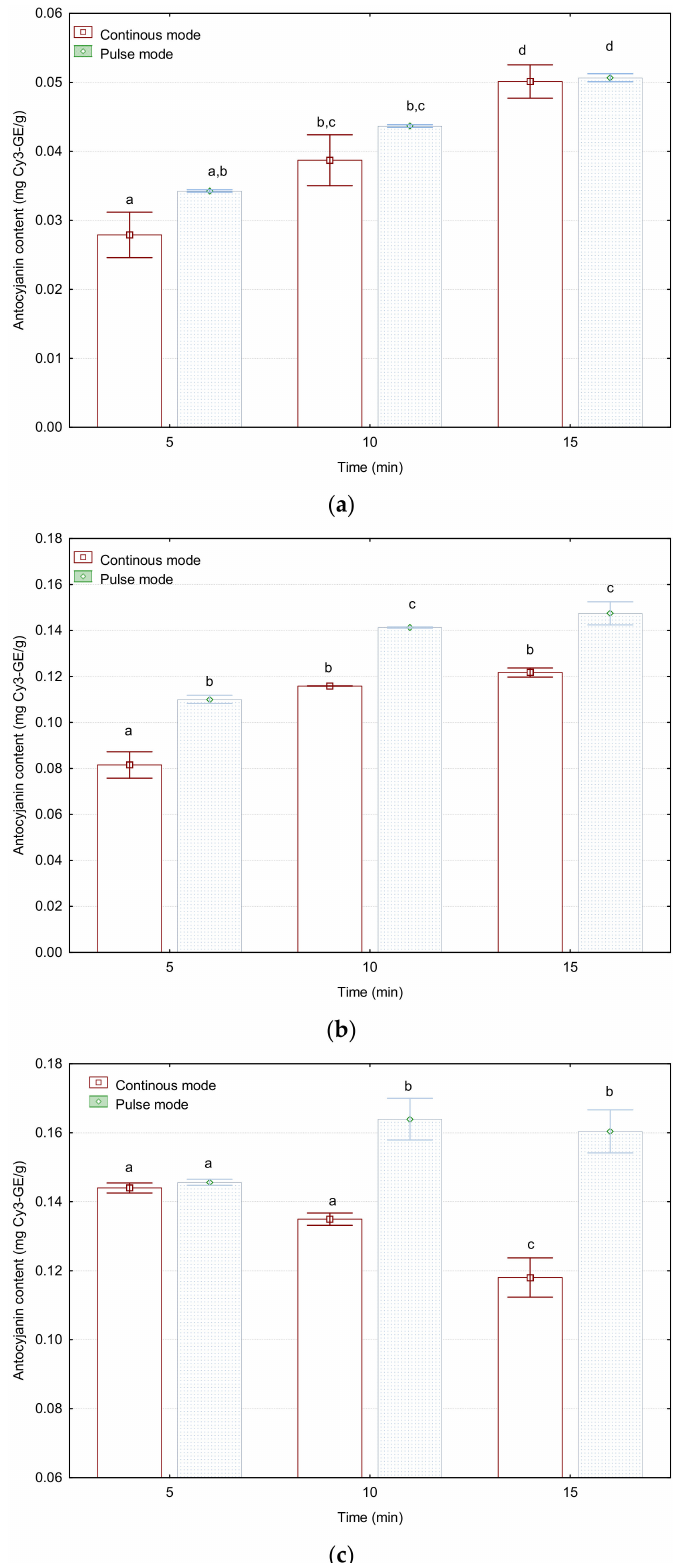
Figure 2. Effect of ultrasonic treatment parameters on the content anthocyanin [mg Cy3-GE/g d.m.] in hawthorn berries extracts: ( a ) amplitude 12 µ m, ( b ) amplitude 24 µ m, ( c ) amplitude 36 µ m. The bars marked with the same letter are not statistically significantly different ( p <